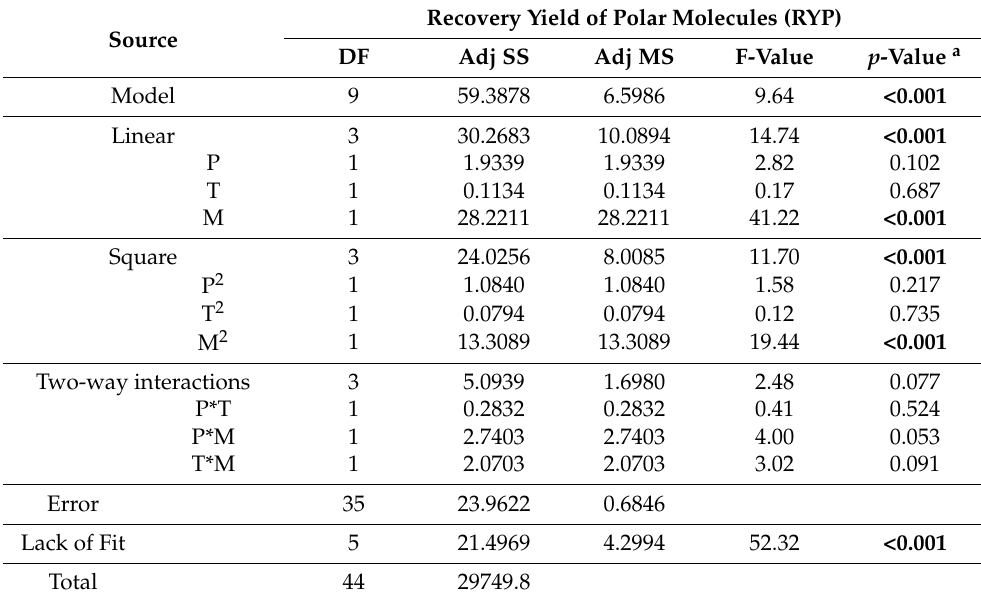
Table 6. ANOVA analysis of Recovery Yield of Polar molecules for SC-CO 2 extraction of SCG.